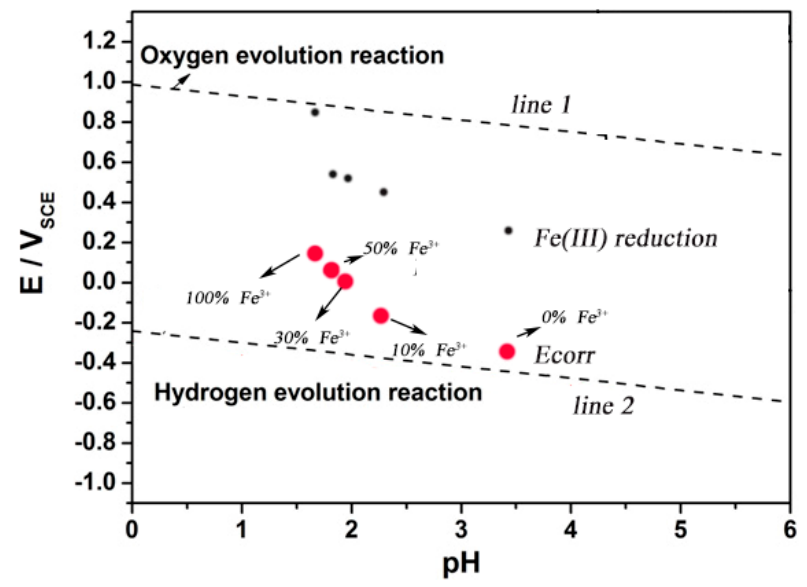
Figure 7. An experimental E - pH diagram of 304 stainless steel at pH varying from 0 to 6.